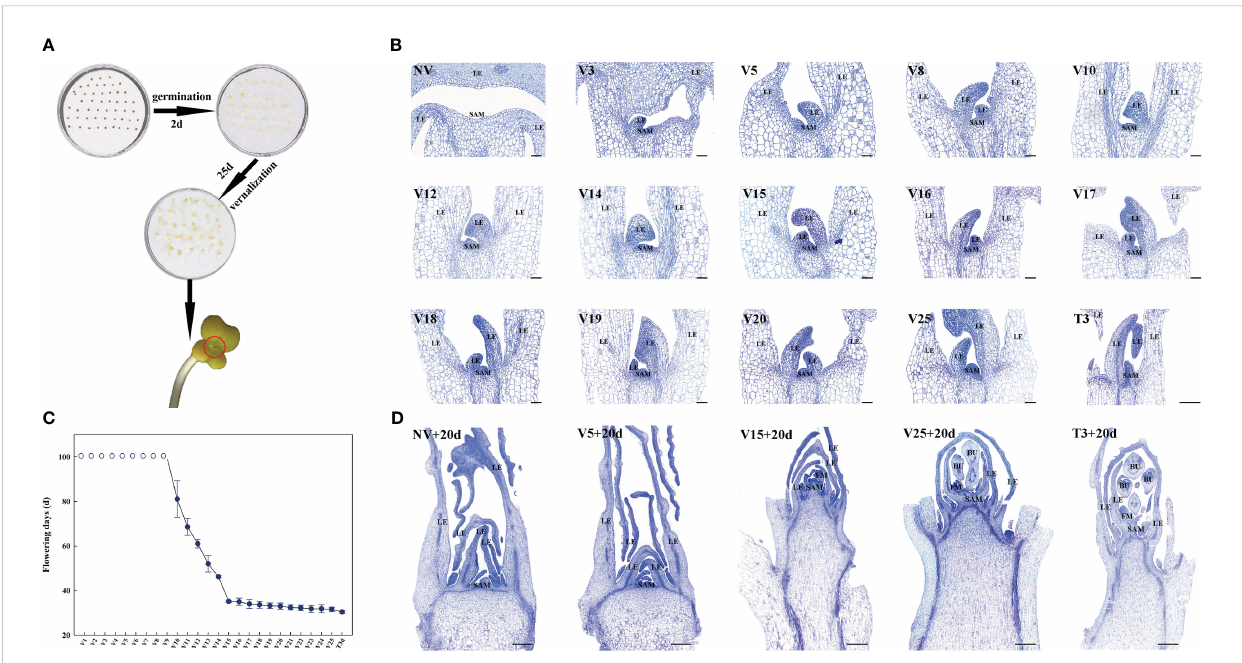
FIGURE 1 Plumule-vernalization and toluidine blue staining of Chinese cabbage to identify RNA-seq samples (short scale bar, 500 m m; long scale bar, 1000 m m). (A) Brief process of germination and plumule-vernalization of Chinese cabbage. (B) Toluidine blue staining of meristems in different plumule- vernalization periods (SAM: shoot apical meristem; LE: leaf or leaf primordia). (C) The number of fl owering times in different plumule-vernalization periods after sowing (the hollow circle represents more than 100 days of fl owering). (D) Toluidine blue staining of meristems in different RNA-seq samples after 20 days of sowing (SAM: shoot apical meristem; LE: leaf or leaf primordia; FM, fl oral meristem; BU: